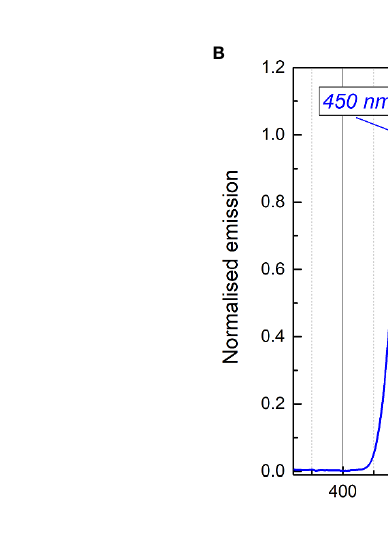
FIGURE 2 Constant irradiance plate 3D model (A) , relative irradiance spectrum (B)